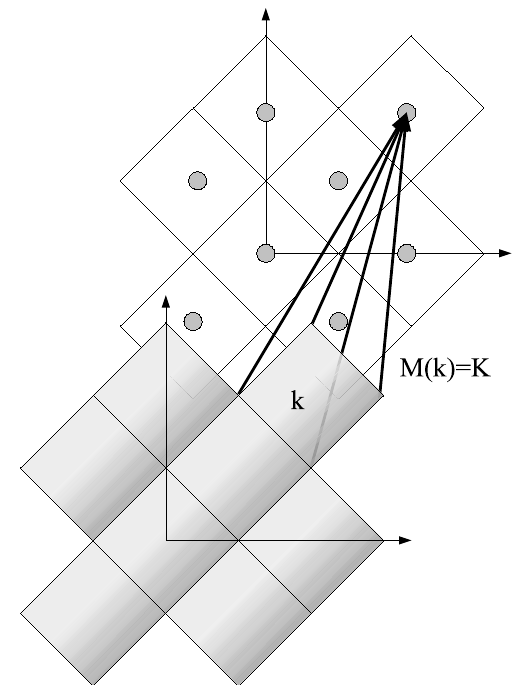
Figure 18. The DCA many-to-few mapping of an arbitrary point in the first Brillioun zone to one of N c = 8 cluster momenta K